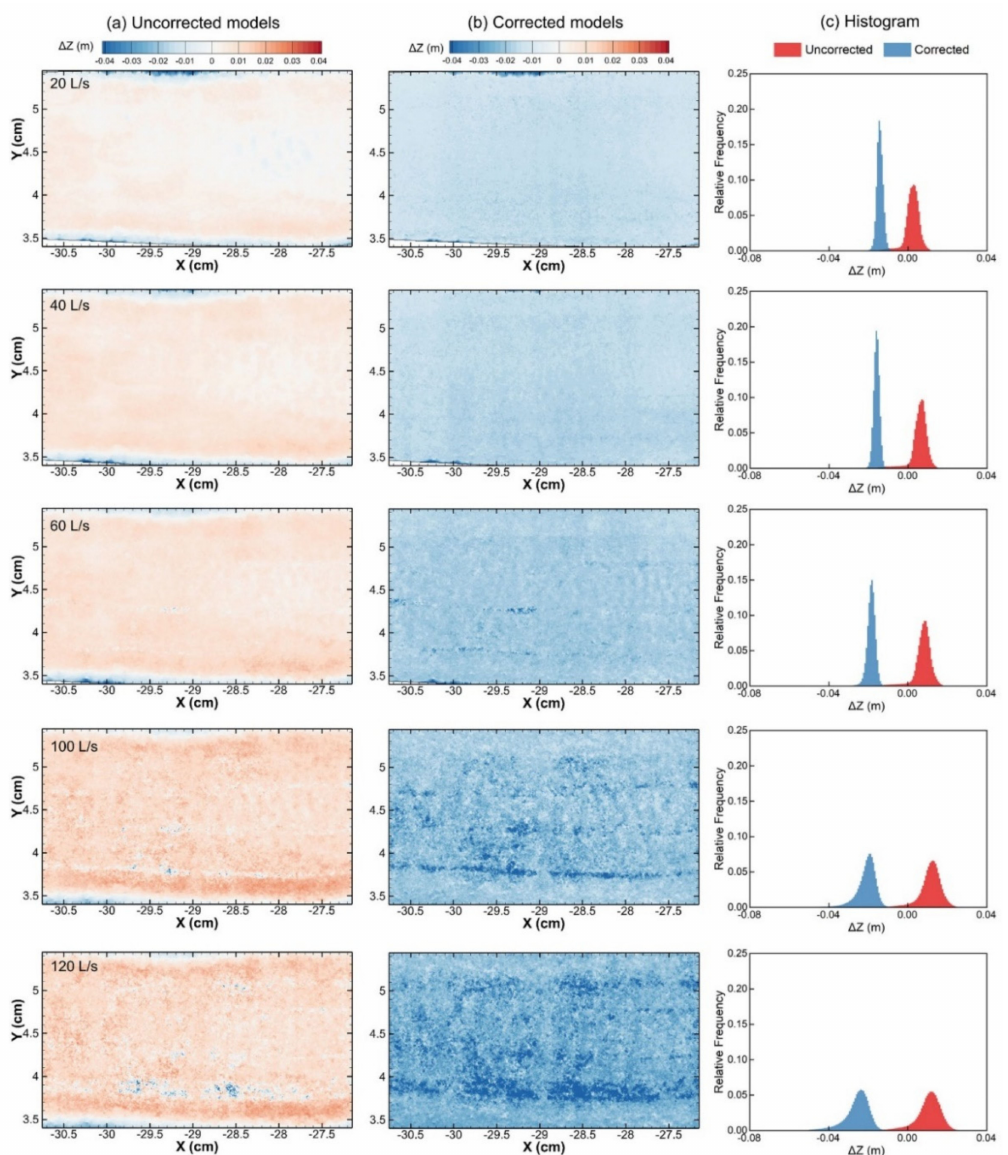
Figure A2. The contours and histograms of elevation errors for the through-water SfM models using all the GCPs for MR1: ( a ) uncorrected models; ( b ) corrected models; ( c ) histograms. Flow goes from the left to the